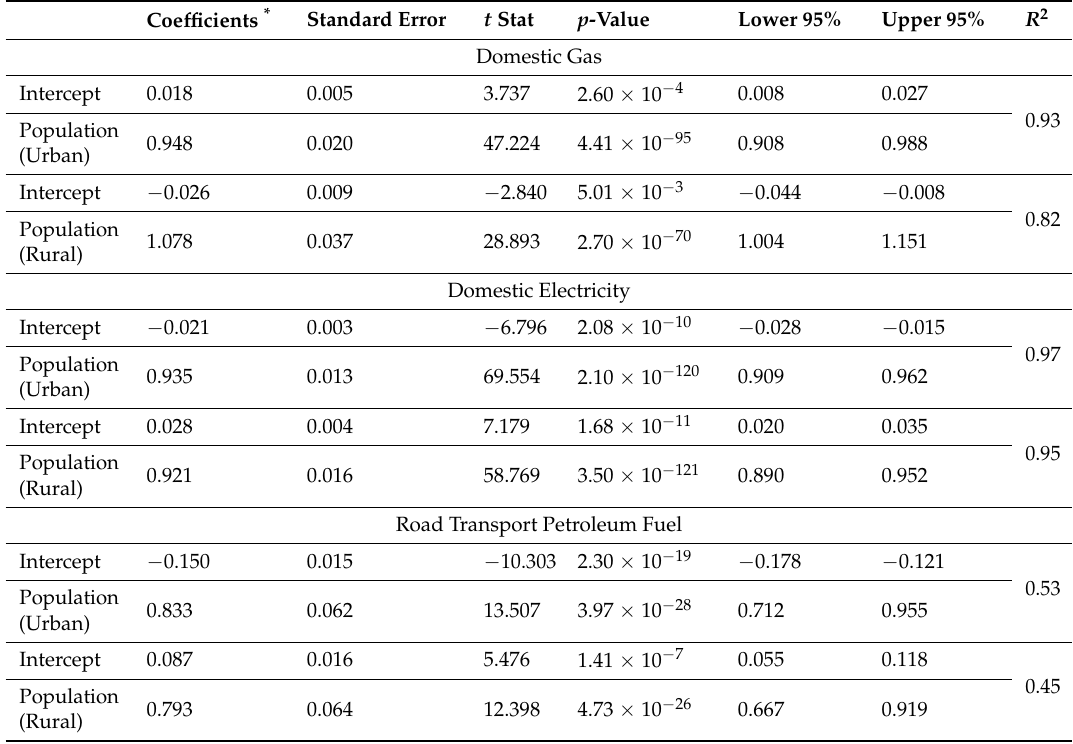
Table 1. Regression analysis report for log-log relationship between average-normalized consumptions and